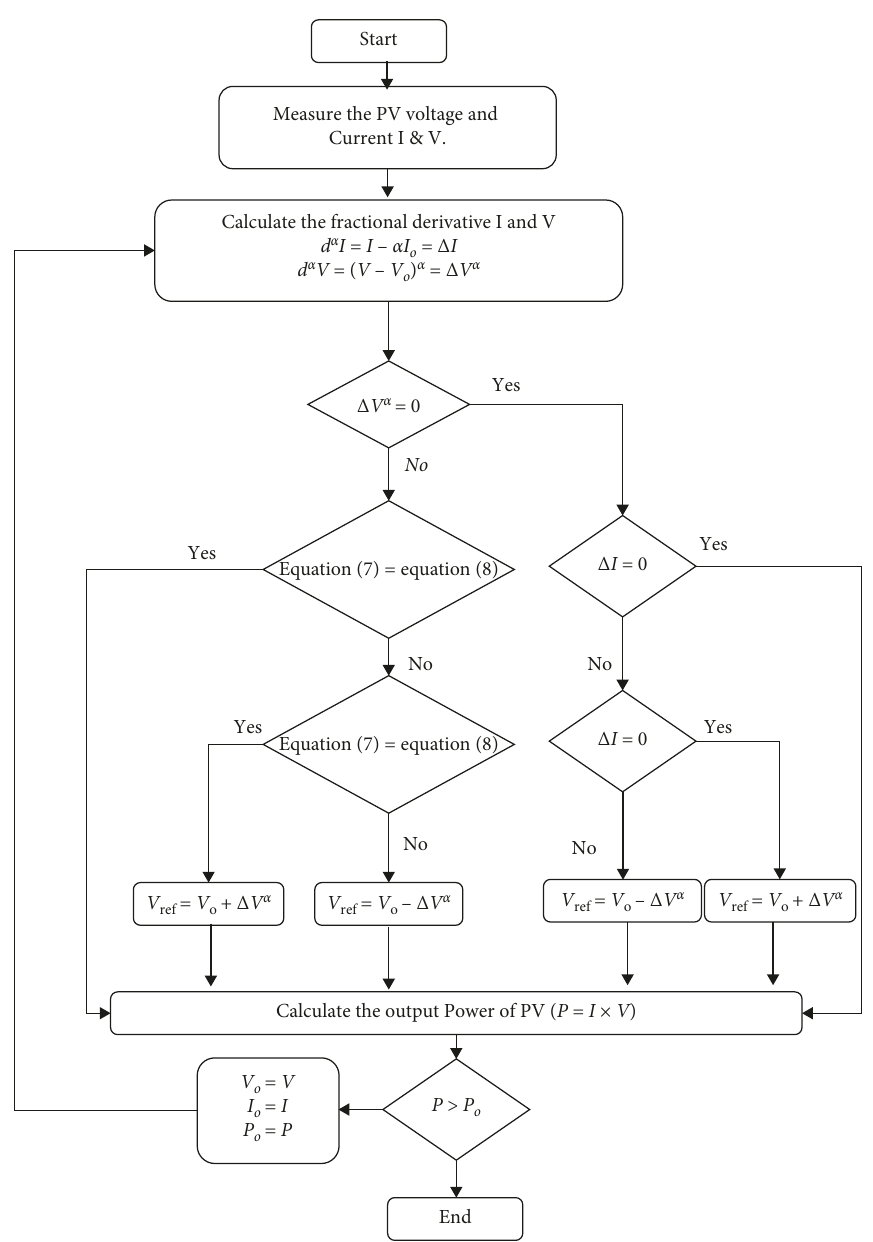
Figure 6: Fractional order INC MPPT